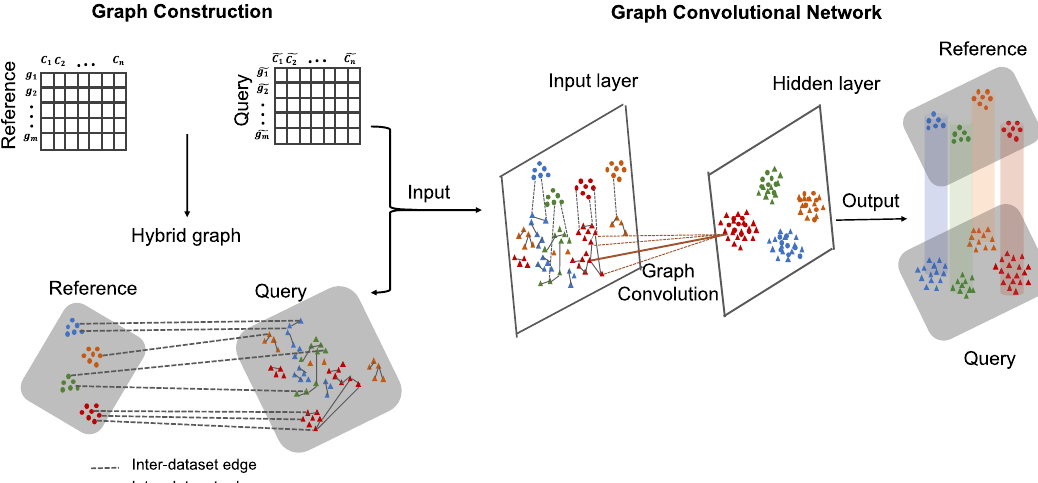
Fig. 1 Schematic overview of scGCN for transferring labels from reference data to query data. scGCN fi rst learns a hybrid graph of both inter-dataset (dash line) and intra-dataset (solid line) cell mappings. In the hybrid graph, round solid-colored dots represent cells of the reference dataset, while the triangles represent cells from the query dataset. Based on the hybrid graph, semi-supervised GCN is used to project cells of both reference and query datasets onto hidden layer so that cells with the same labels present in the same subpopulation. Thus, cell labels in query data are predicted and learned from reference